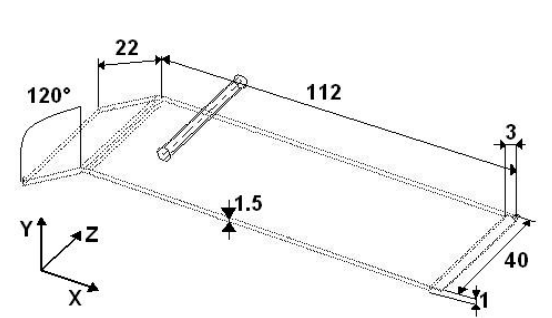
Fig. 5. Plastic part dimensions and one cooling